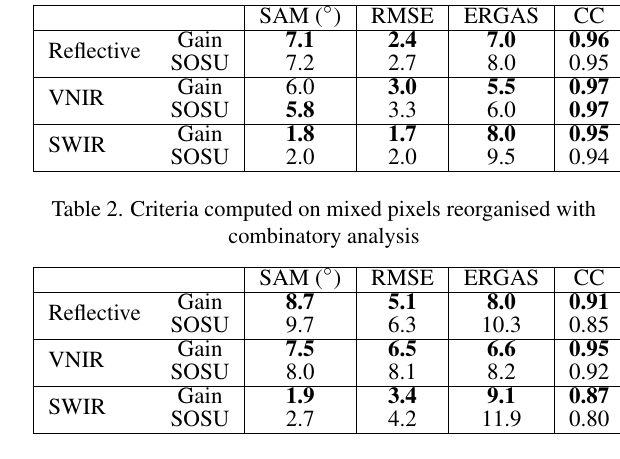
Table 3. Criteria computed on mixed pixels reorganised without combinatory analysis